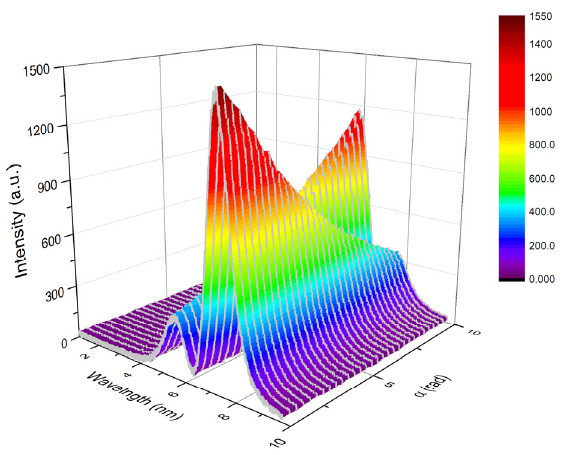
Figure 4. The output spectra of the weak measurement system with varied α angle.